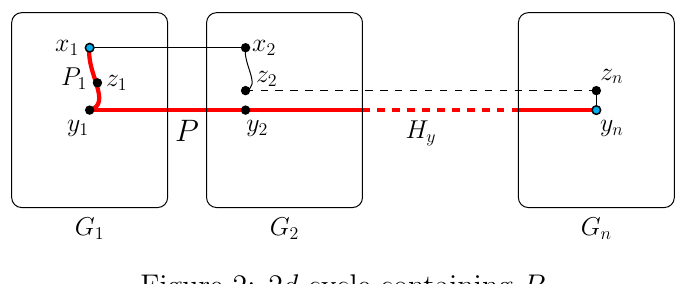
Figure 2: 2 d -cycle containing P